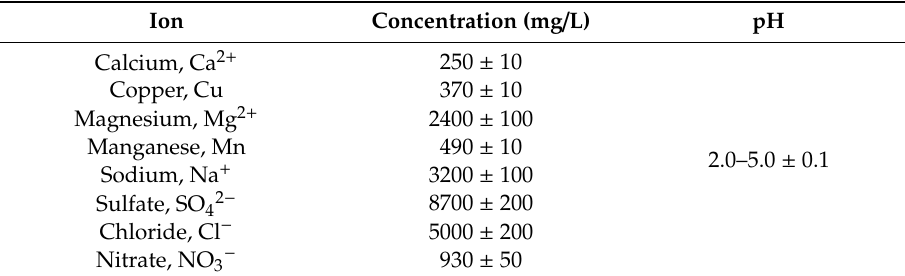
Table 4. Model AMD solution feed composition used in the present study.